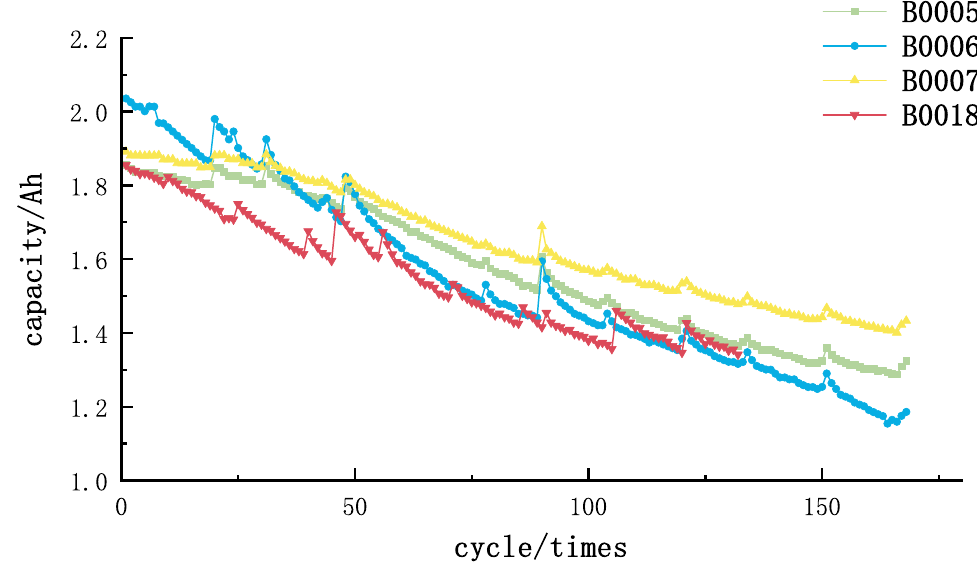
Figure 5. Lithium-ion battery decay trend